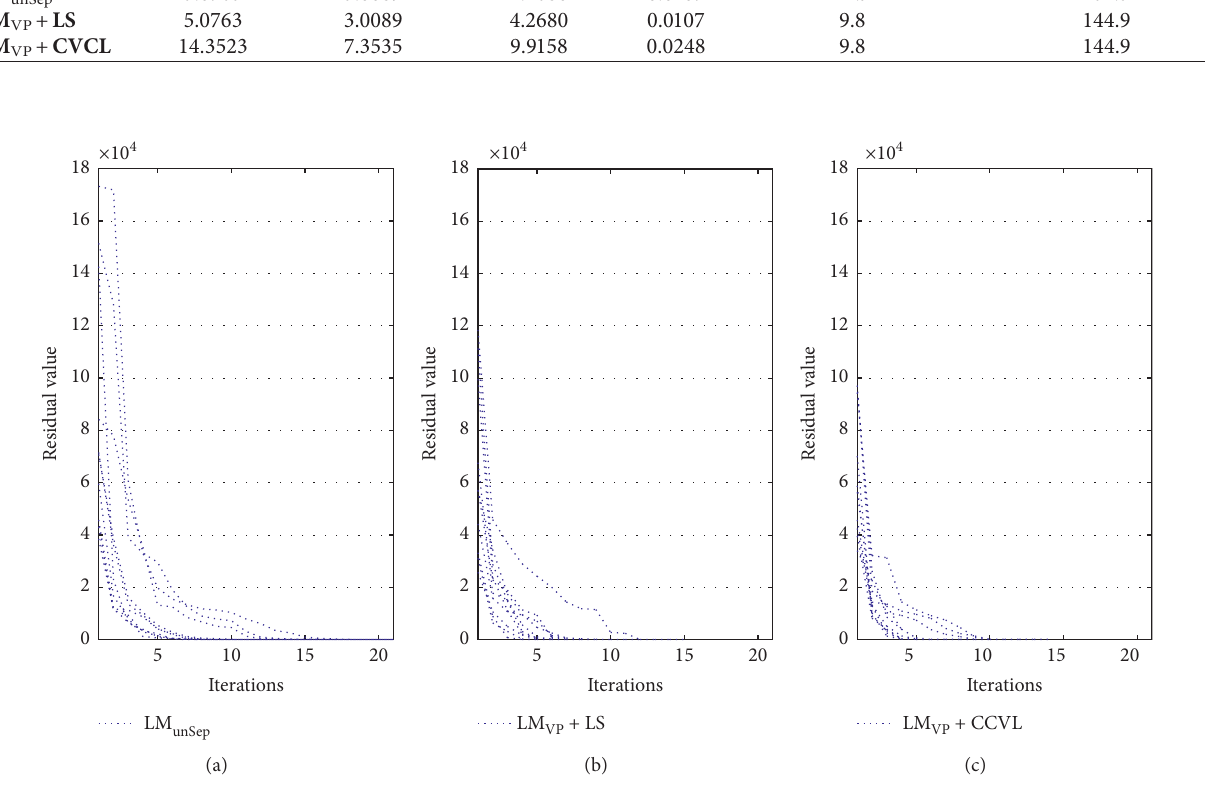
Figure 4: Residual changes of the three methods in the iteration process for Example